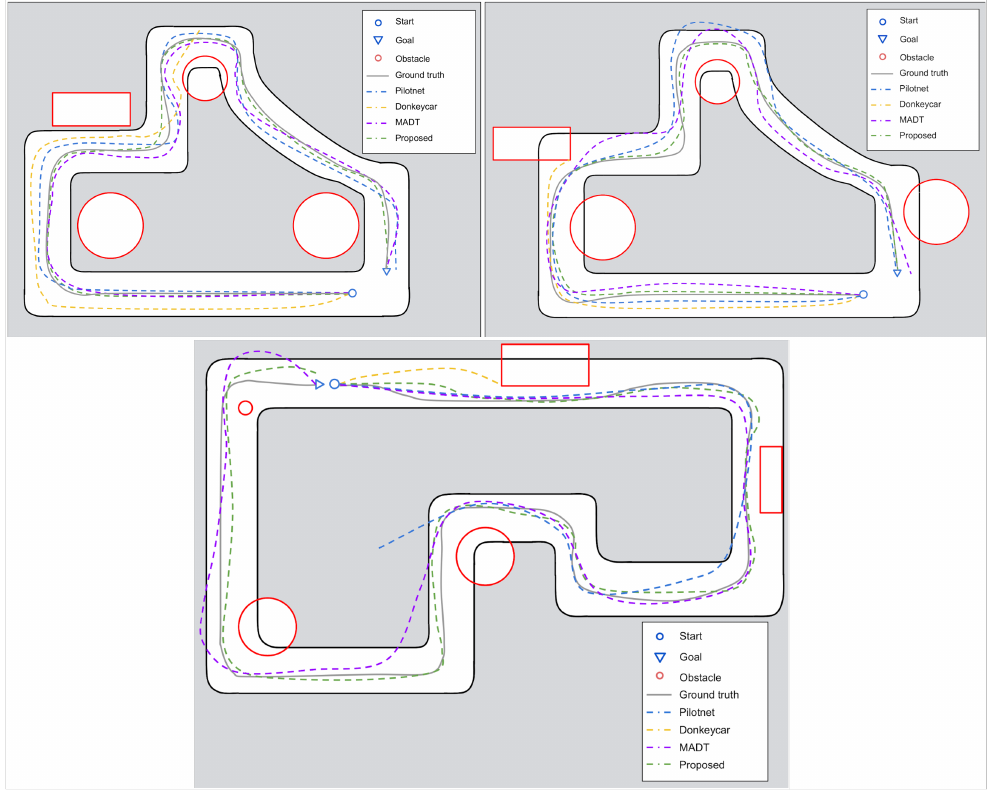
Figure 12. Trajectories obtained during self-driving in physical